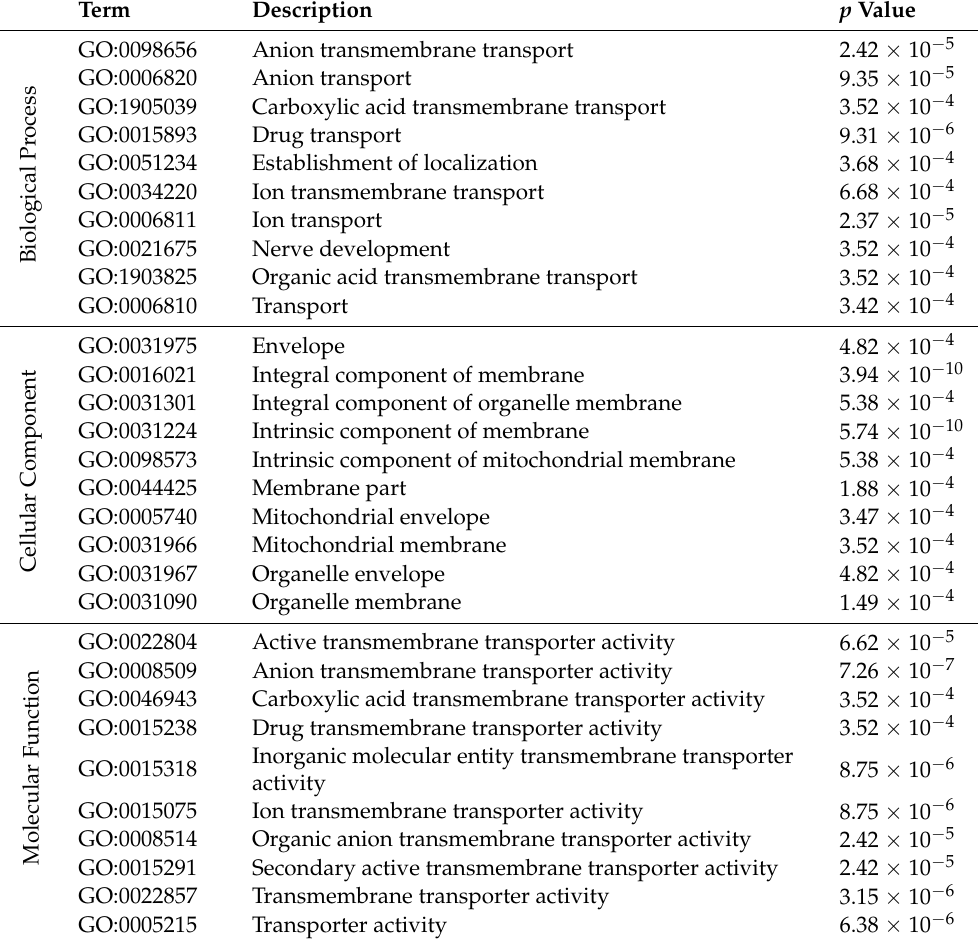
Table 4. Gene ontology classification results of differentially expressed proteins of 24 h vs. 6 h PM.